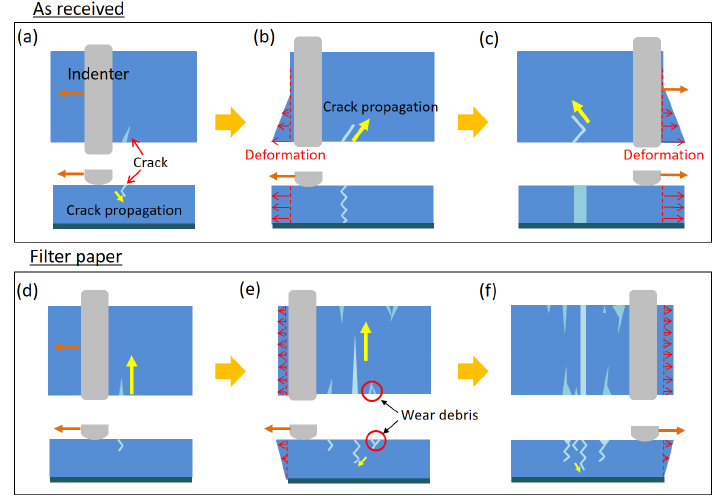
Figure 4. Schematic of propagation mechanisms of fatigue cracks and formation mechanisms of wear debris for ( a – c ) As received and ( d – f ) Filter paper